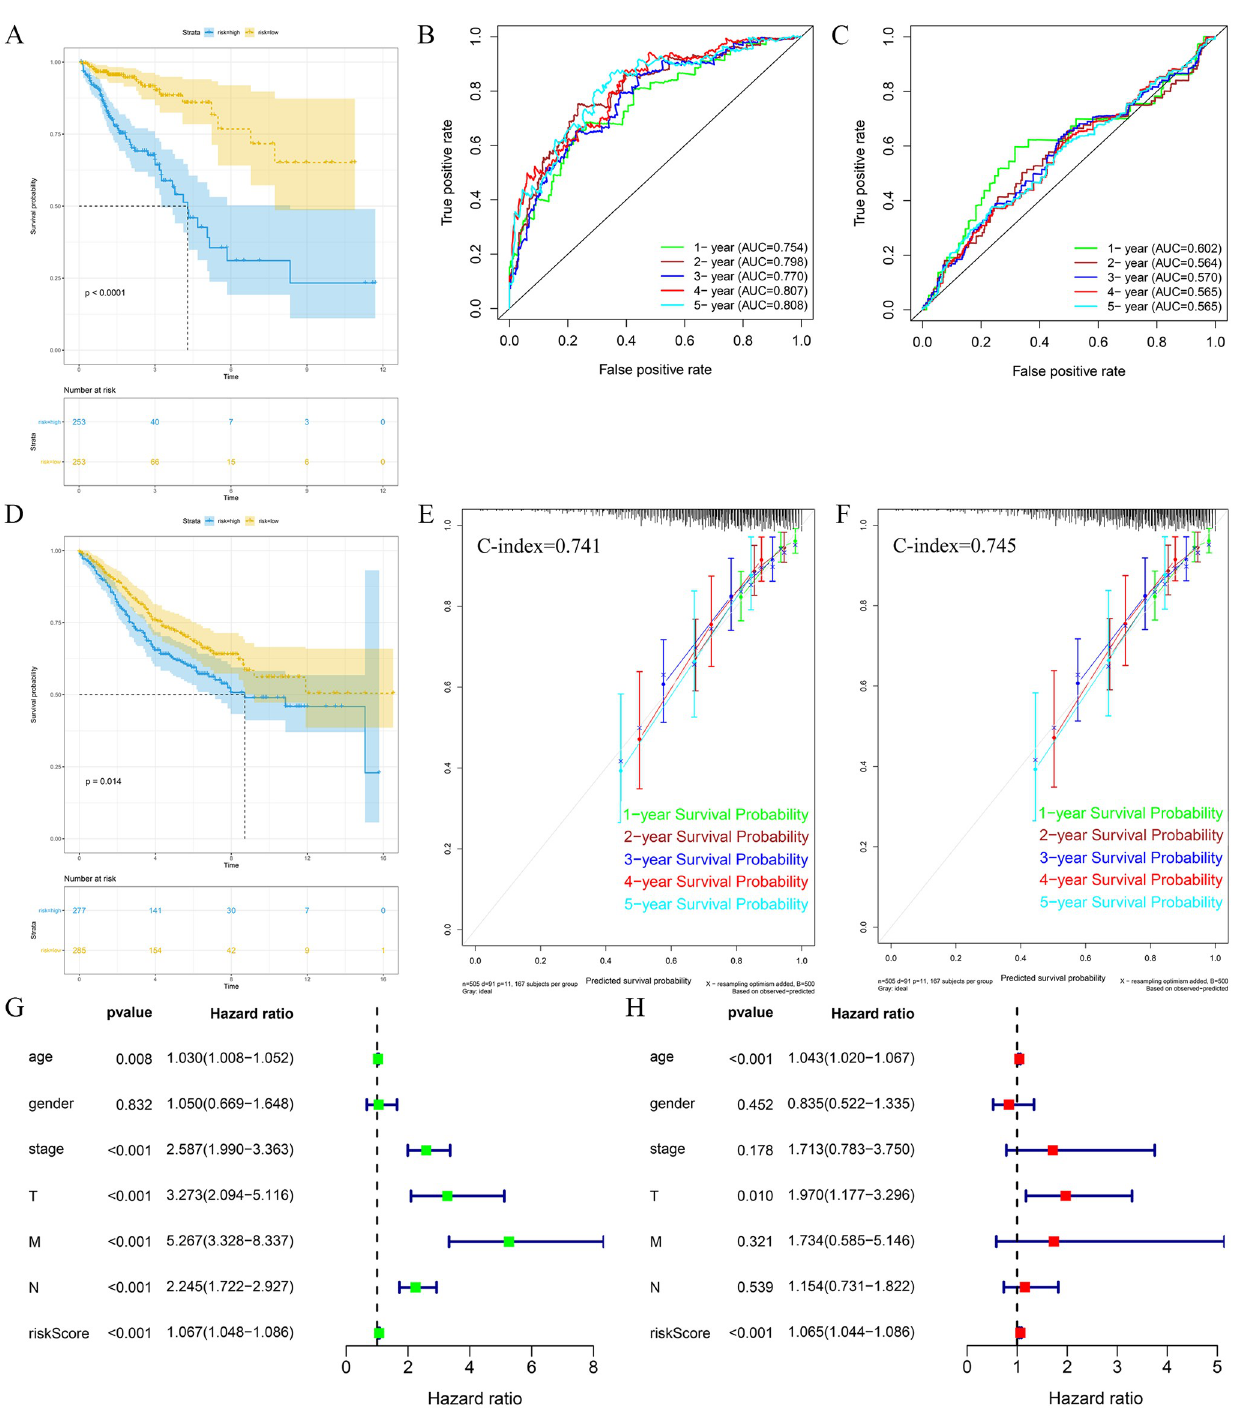
Fig 3. Survival analysis, independent prognostic analysis and verification of the model. The survival analysis of the TCGA-CRC(A) and GSE39582(D) cohorts showed that the overall survival rate of patients in the high-risk group was lower than that in the low-risk group. The ROC analysis of the TCGA-CRC(B) and GSE39582(C) cohorts showed that the prognostic model used to predict the prognosis of CRC is accurate. The C-index and calibration curve analysis of the TCGA-CRC(E) and GSE39582(F) cohorts showed that the prognostic model has strong accuracy in predicting the prognosis of CRC. Univariate (G) and multivariate (H) COX analysis of the TCGA-CRC cohort showed that the prognostic model can be used as an independent risk factor to predict the prognosis of CRC.